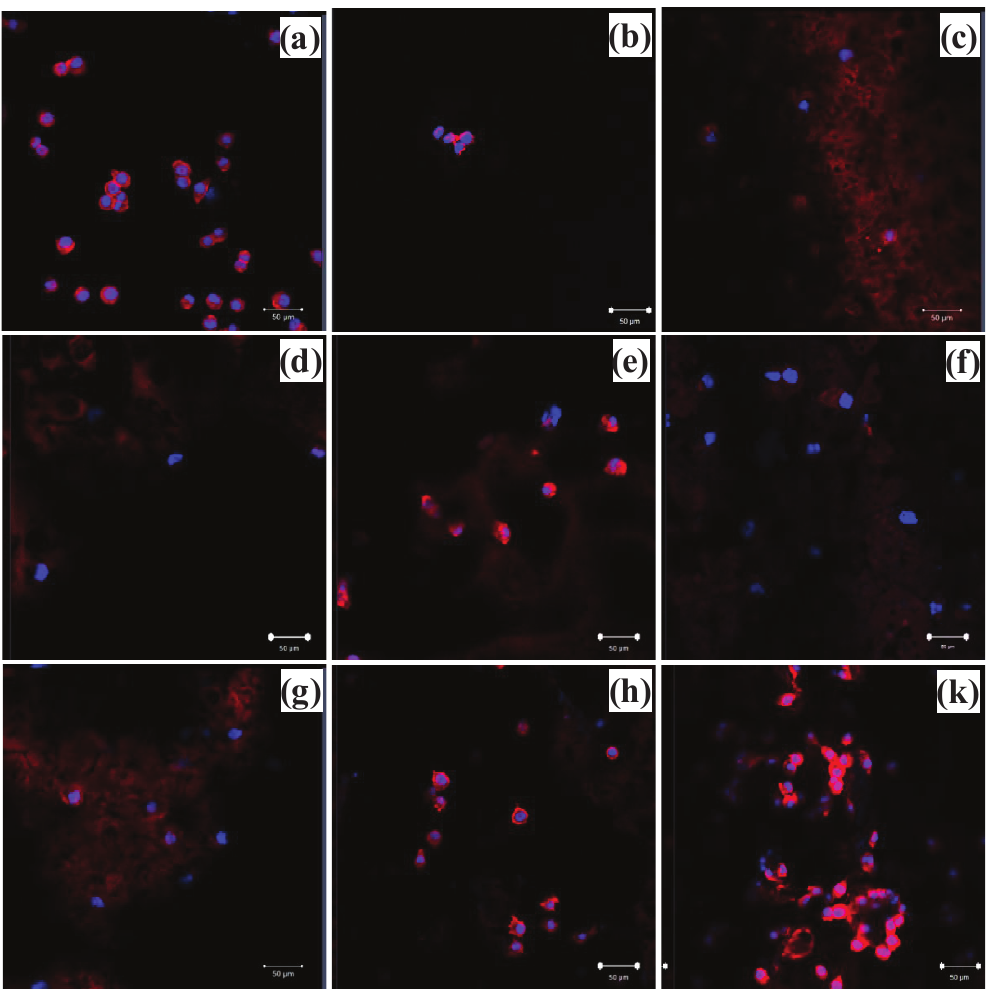
Figure 12: Confocal laser scanning microscopy images of L-929 fibroblasts on scaffolds, cultured for 24 h: (a) TCPS, (b) PLA dense scaffold without pore and (c) porous scaffold without HA. (d), (e) and (f) are the images from PLA scaffol ds that contained HA ranging from 5%, 10% to 15% respectively and (g), (h) and (k) are the images from PLA scaffolds that contained HA grafted collagen ranging from 5%, 10% to 15%, respectively (scale bar = 50